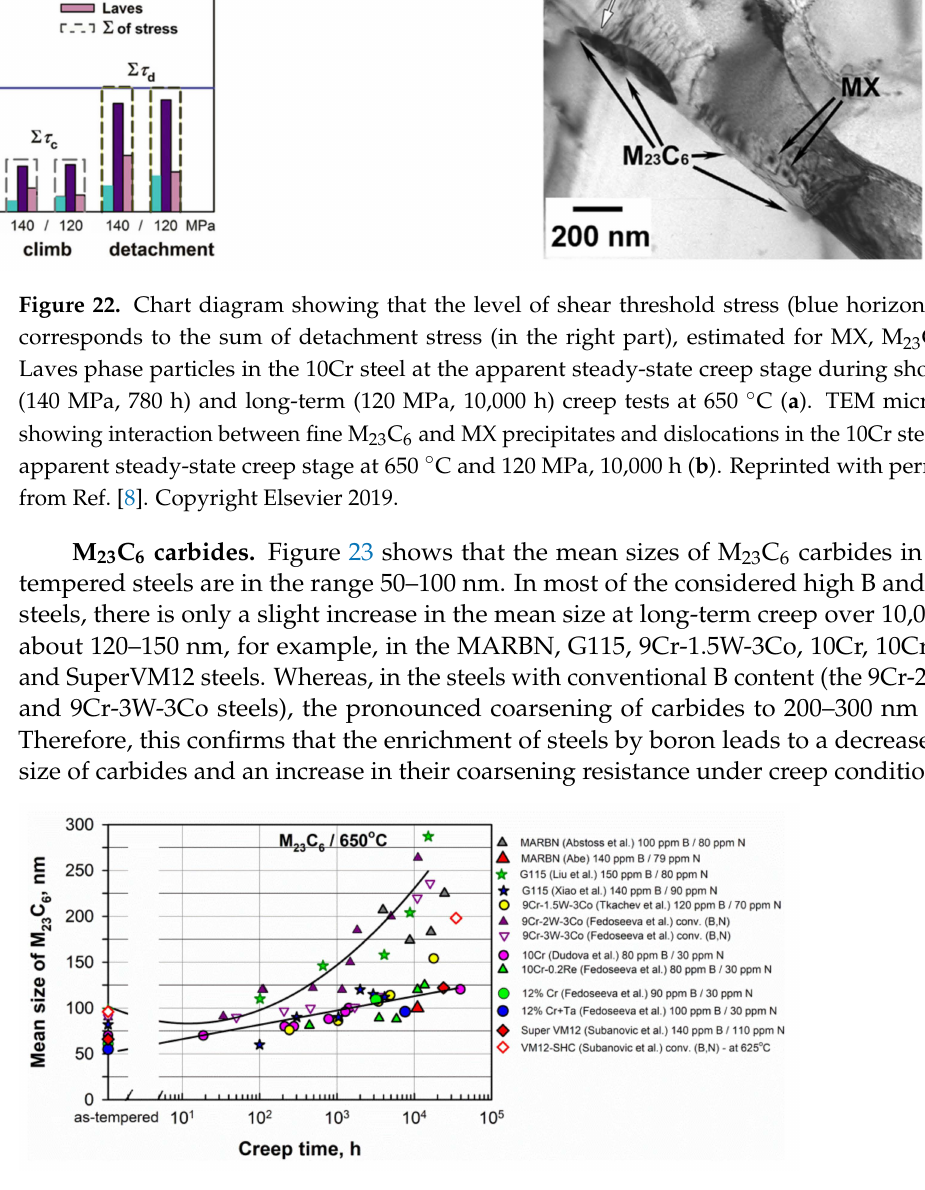
Figure 23. Evolution of the mean size of M 23 C 6 carbides during creep in the 9–12% Cr steels. Data from